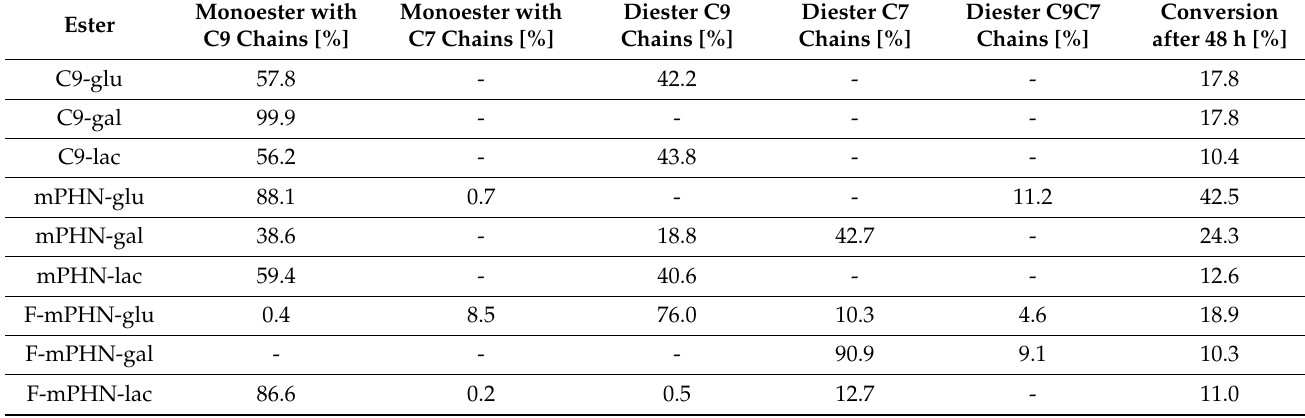
Table 1. Molar composition of sugar fatty acid ester based on LC-MS QQQ analysis and conversions of reactions. Monoester Ester